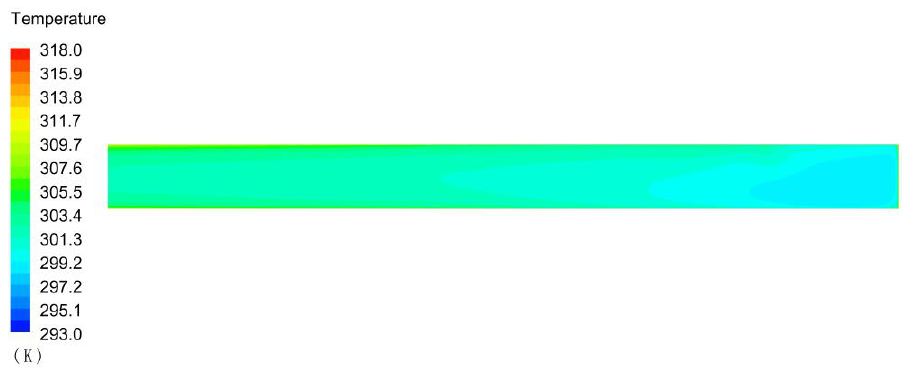
Figure 13. Model 4 section temperature distribution.